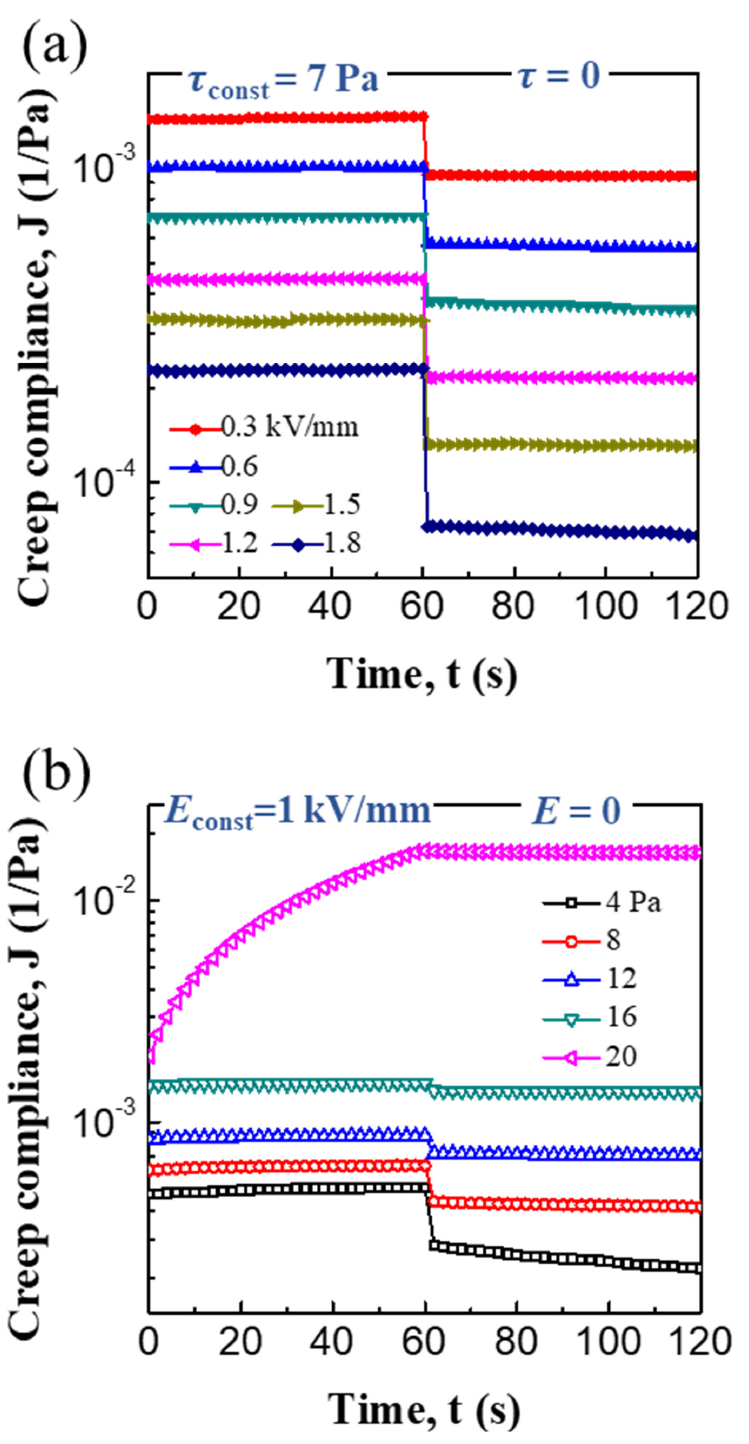
Figure 12. Creep compliance vs. time under ( a ) constant stress and ( b ) constant electric field strength of GO/PDPA microsheet composites-based ER fluid (10 vol.%).